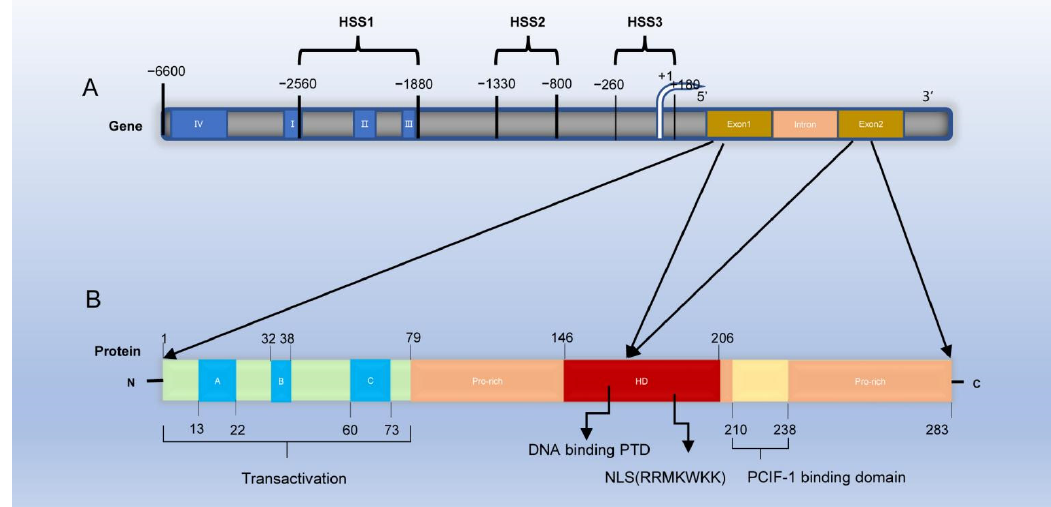
Figure 1. Structure of PDX-1 gene and protein. ( A ) PDX-1 gene contains two exons: exon 1 encodes the NH2-terminal domain and some homeodomain of PDX-1 protein, and exon 2 encodes the remaining homeodomain and COOH-terminal domain. Three nuclease-hypersensitive sites were identified within the 5 ′ -flanking region of the endogenous PDX-1 gene: HSS1 ( − 2560~ − 1880 bp), HSS2 ( − 1330~ − 800 bp) and HSS3 ( − 260~+180 bp). Among them, HSS1 is an important functional region of PDX-1 gene transcription activation and includes four sub-regions, region I ( − 2694~ − 2561 bp), region II ( − 2139~ − 1958 bp), region III ( − 1879~ − 1799 bp), and region IV ( − 6200 and − 5670 bp). ( B ) PDX-1 protein comprises 283 amino acids. The NH2-terminal is a proline-rich transcriptional activation domain, including 1~77 amino acids (amino acid AA or aa), which is composed of three highly conserved subdomains A, B, and C (A:13 − 22aa B:32 − 38aa C:60 − 73aa). The homeodomain (HD) is composed of 146~206 amino acids, which contains three highly conserved helical regions: helix1, helix2, and helix3 (H1 H2 H3); the nuclear localization signal (NLS) is part of H3. The COOH-terminal is composed of 238~283 amino acids, and the conserved motif (210~238 amino acids) mediates the interaction of PDX-1-PCIF1 (PDX-1 C-terminal interacting factor-1) and inhibits the transcriptional activity of